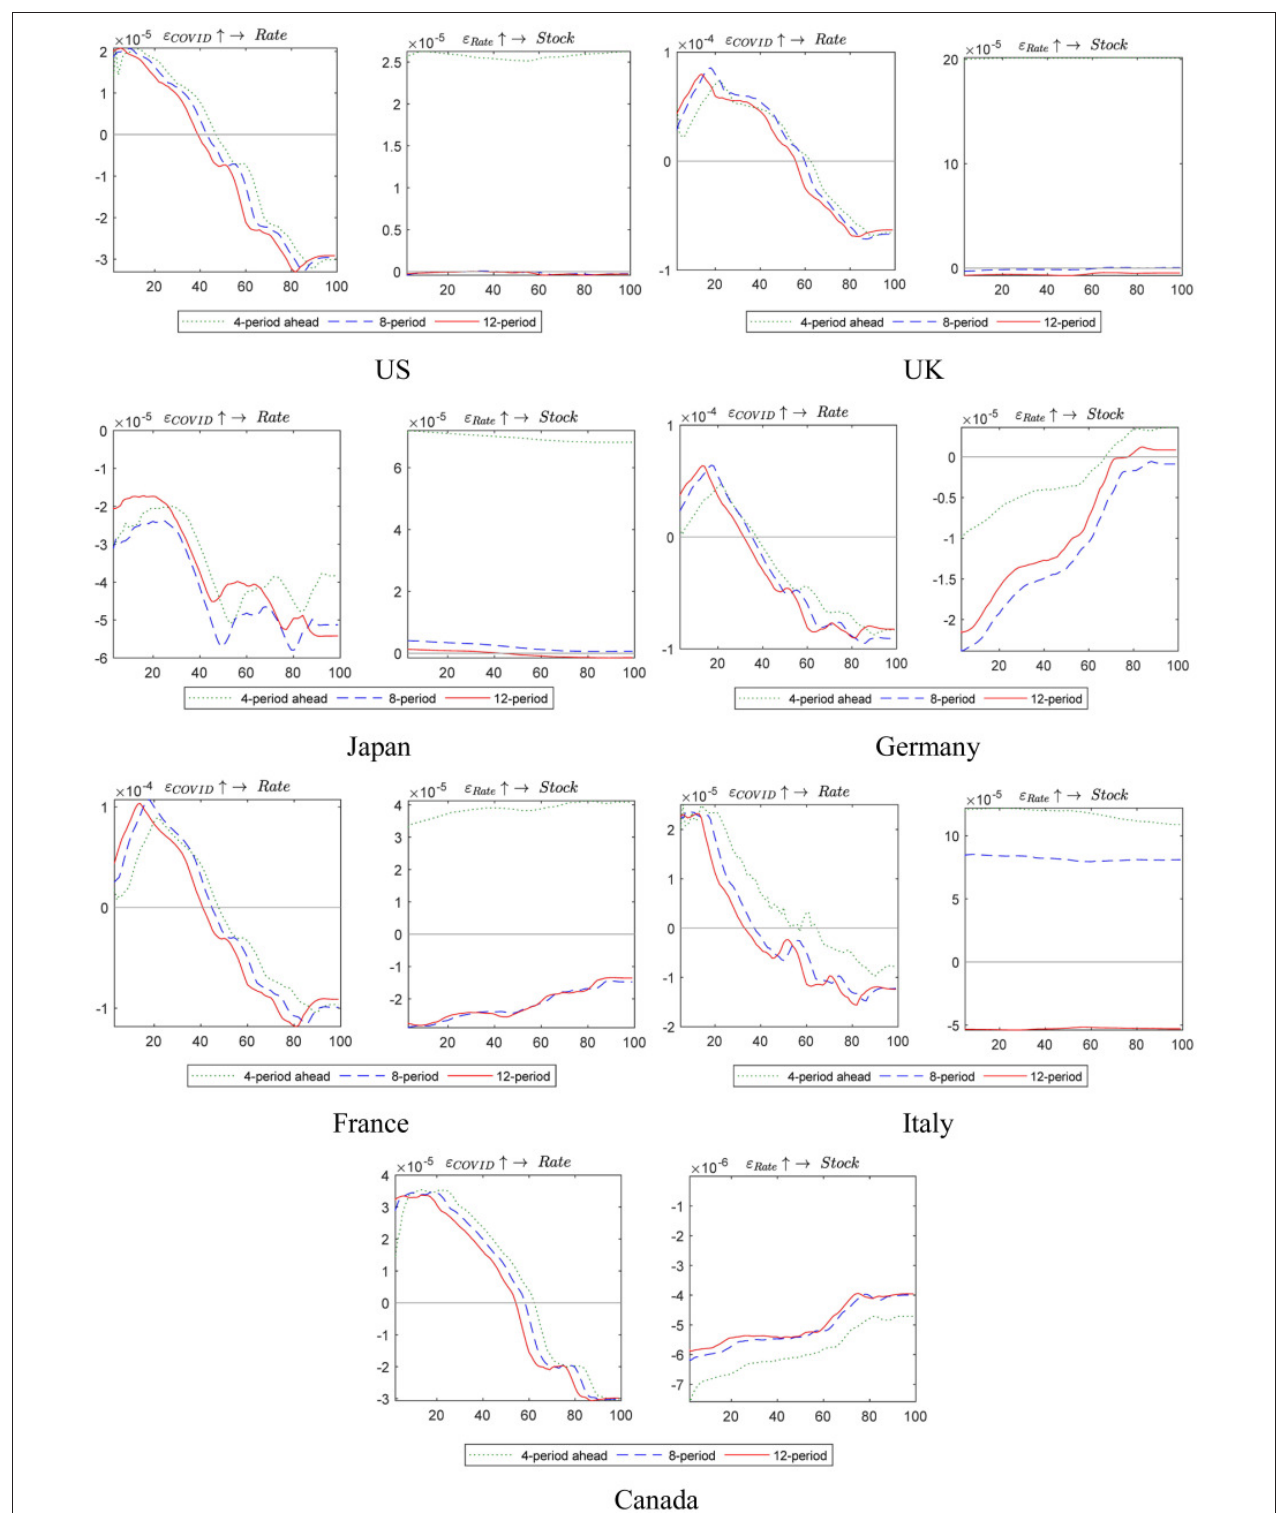
FIGURE 2 | The pulse impact of the COVID-19 epidemic on the exchange rate channel of stock returns.